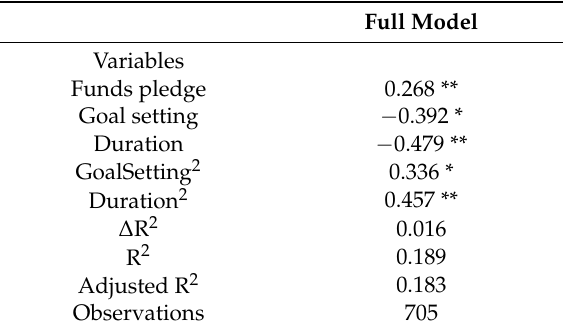
Table 3. Results of robustness